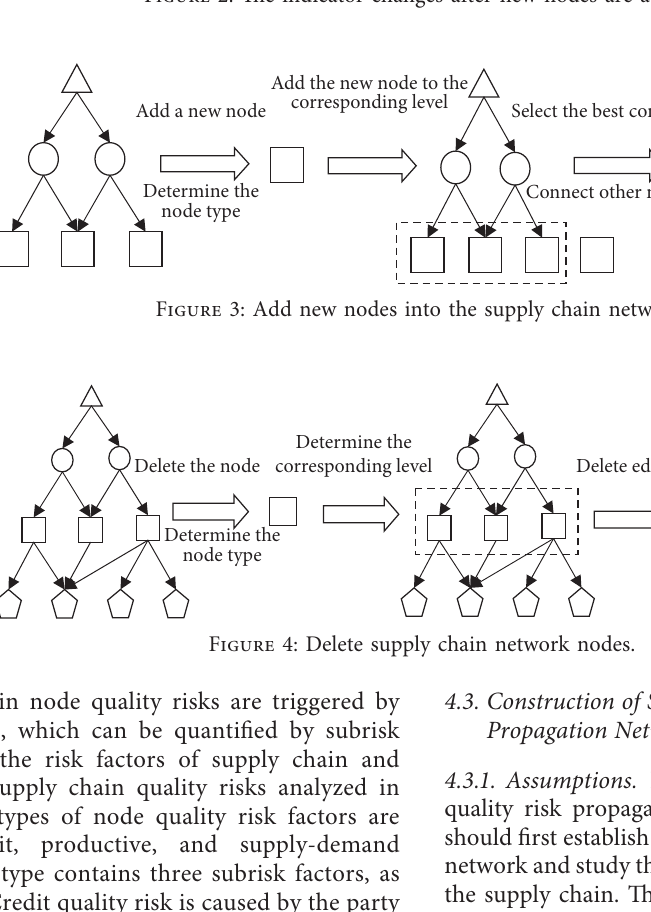
Figure 2: The indicator changes after new nodes are added.